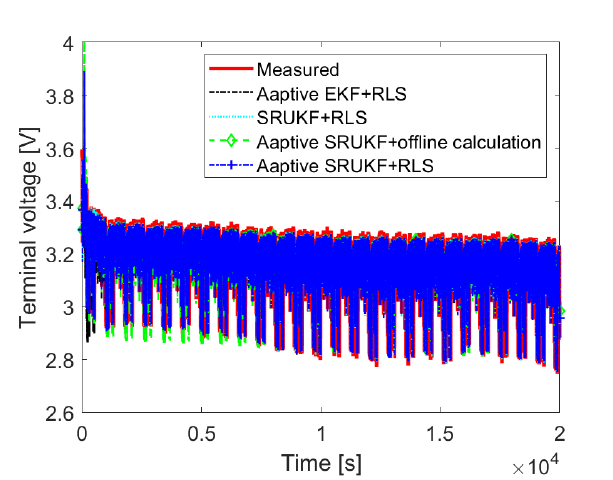
Figure 11. Comparison of the measured and simulated terminal